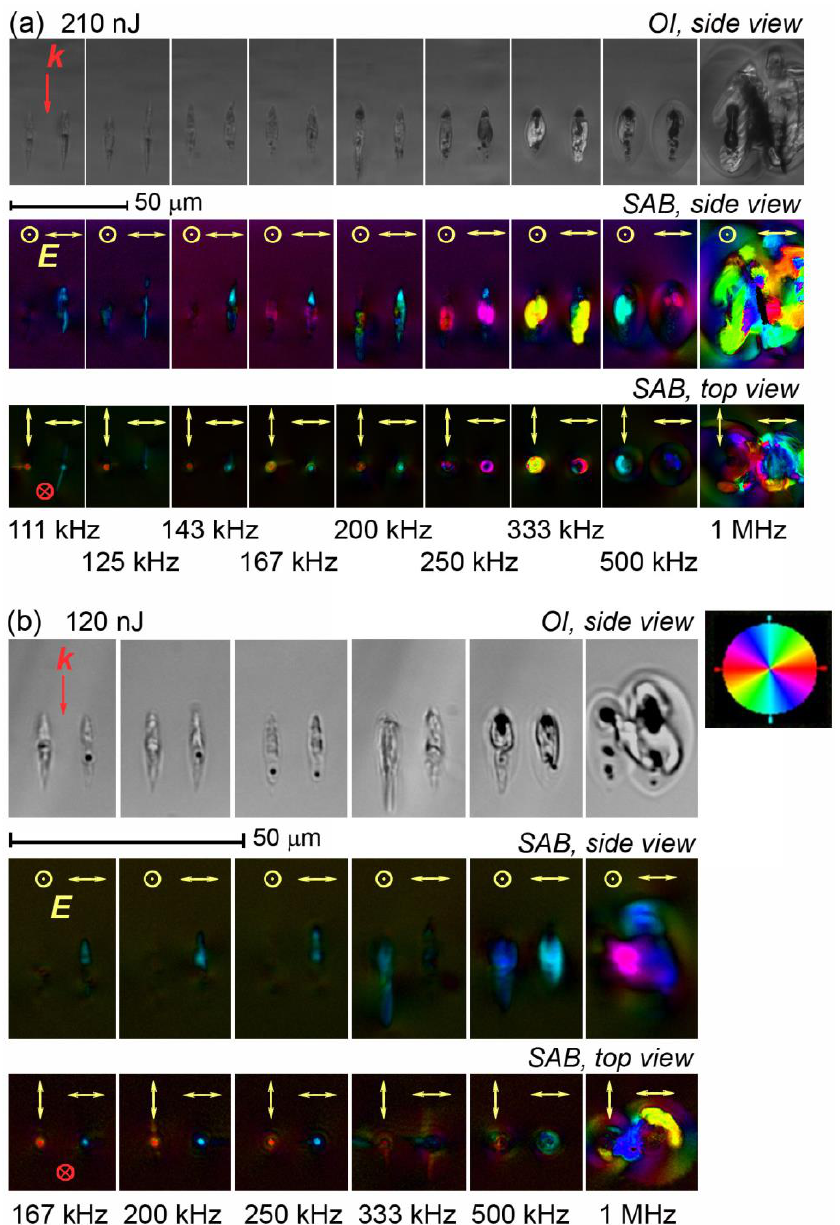
Figure 1. Brightfield optical images (OI) of the side view and pseudocolor maps of the orientation of the slow axis of birefringence (SAB) of the dots written in SG22 glass by 10 6 laser pulses per dot at the pulse duration of 1.2 ps and the pulse energy of 210 nJ ( a ) and 120 nJ ( b ) and the varied PRR and polarization plane orientation E (indicated in yellow). The notation k (indicated in red) is for the wave vector